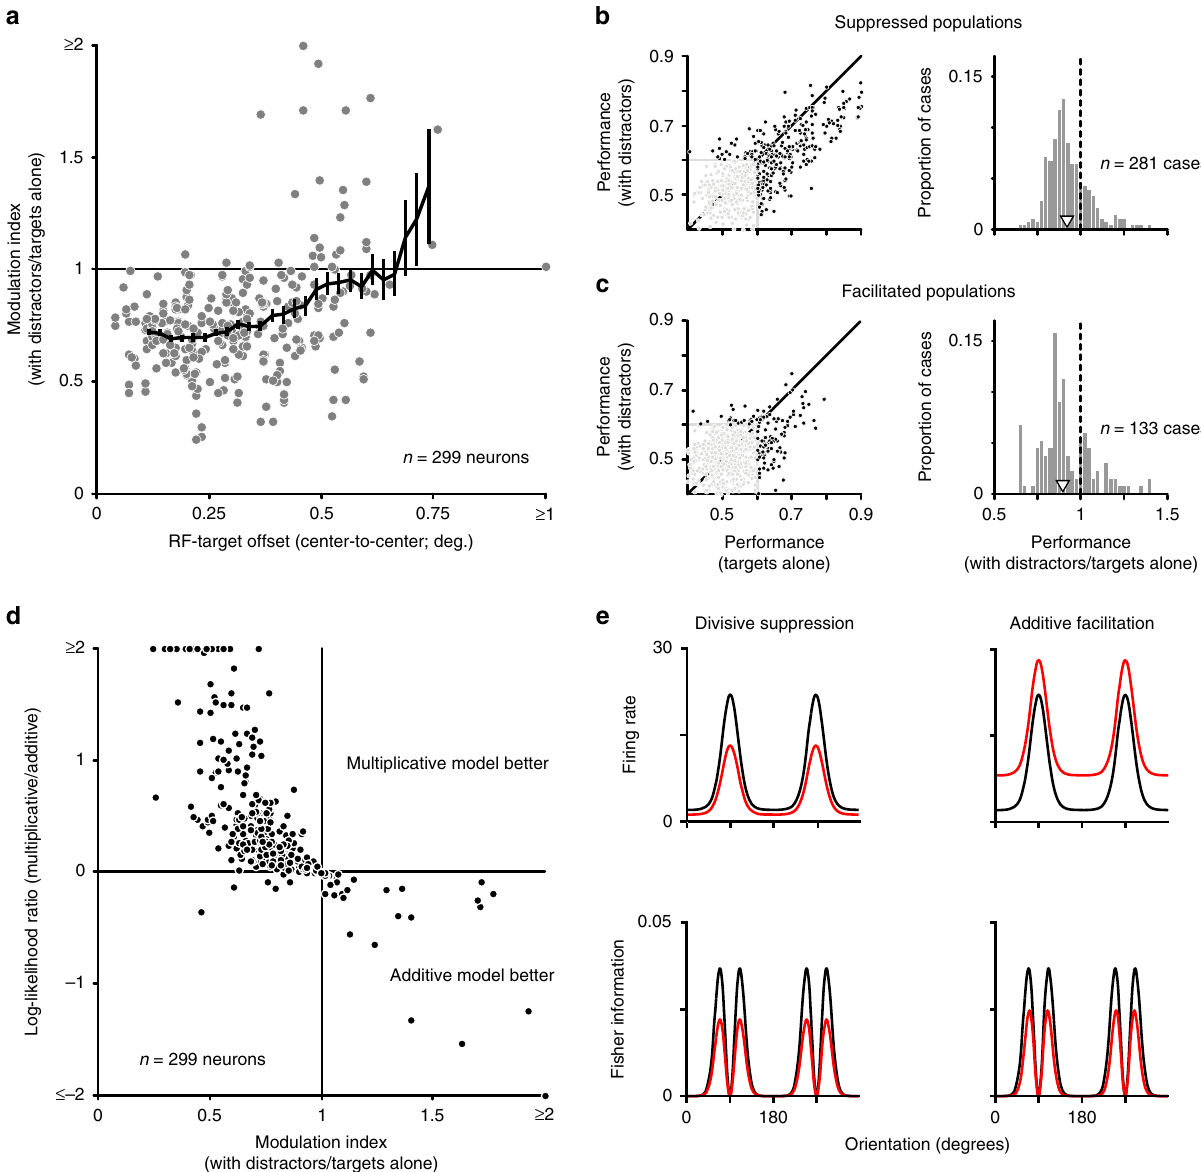
Fig. 7 Suppressed and facilitated populations both show information loss with distractors. a The modulation index as a function of neuronal RF offset from the target location. Black line indicates running mean, in 0.15° windows. b Left: discrimination performance in neuronal subpopulations with strong response suppression with distractors (modulation index ≤ 0.5), for targets with distractors compared to targets alone. Each point represents performance of one population to one pair of gratings. Black dots indicate cases in which performance exceeded the 95% con fi dence interval for chance performance for at least one condition ( n = 281). Right: the ratio of performance for displays with distractors compared to those with targets alone. Only cases in which population performance exceeded chance are considered. Open arrowhead indicates mean. c Discrimination performance for neurons showing response facilitation with distractors (modulation index ≥ 1). 133 cases of signi fi cant performance (black dots). Conventions as in b . d Fit quality of multiplicative compared to additive models, in accounting for altered responses with distractors, as a function of the modulation index. e Top: tuning of model neurons, illustrating how responses for targets alone (black) are modulated by divisive suppression (red, left) and additive facilitation (red, right). Bottom: the Fisher information provided by each neuron, assuming Poisson variability. With distractors (red), Fisher information is reduced by both forms of modulation. Source data are provided as a source data fi